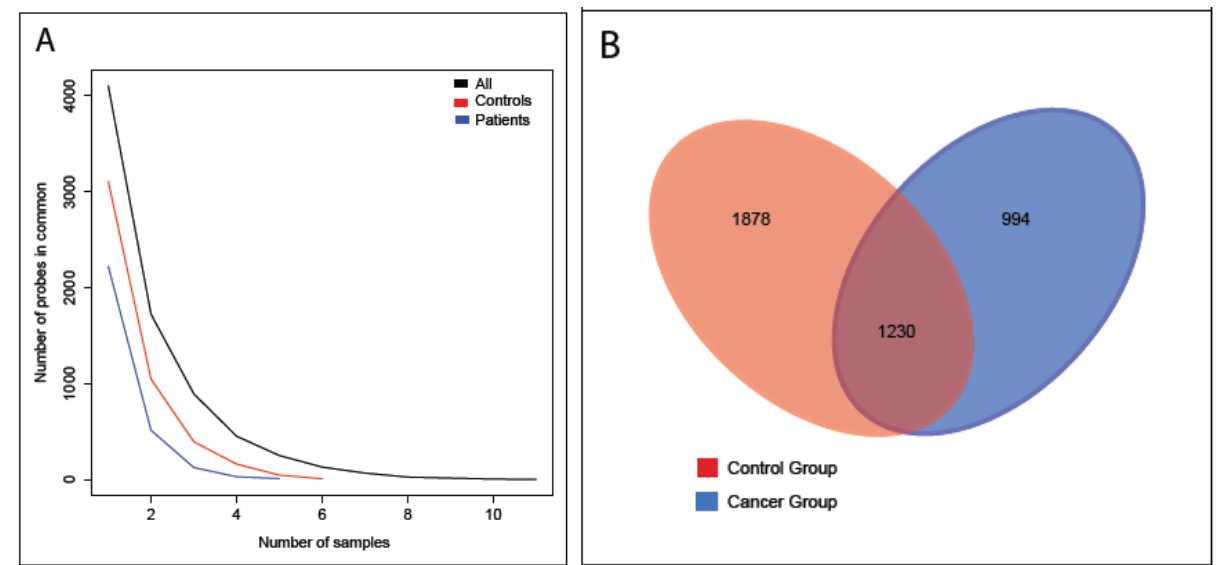
Figure 2. RNA distribution between samples. In ( A ) we show how decreases the number of common genes between an increasing number of samples. Notice that the number of transcripts detected in the control group (red) is larger than the one from cancer group (blue). ( B ) The Venn diagram presents the number of common and unique probes, at least in one sample of the respective